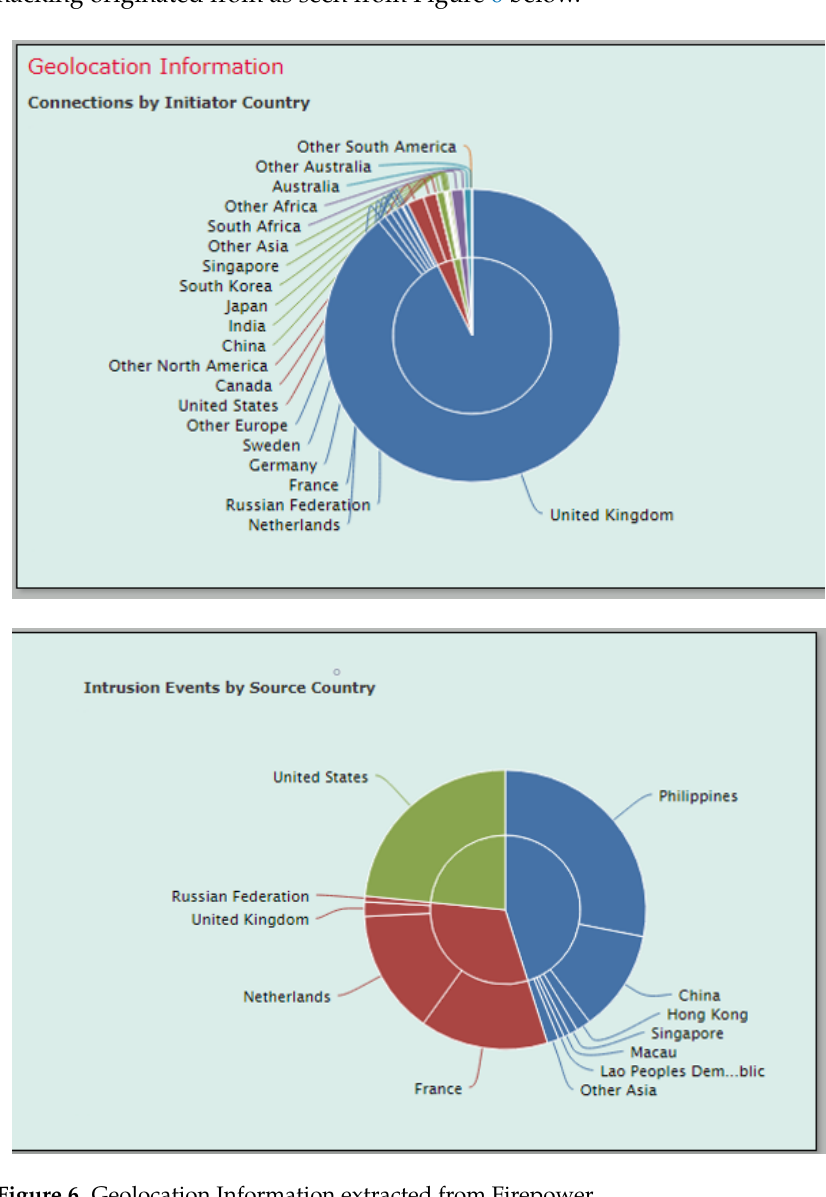
Figure 6. Geolocation Information extracted from Firepower.